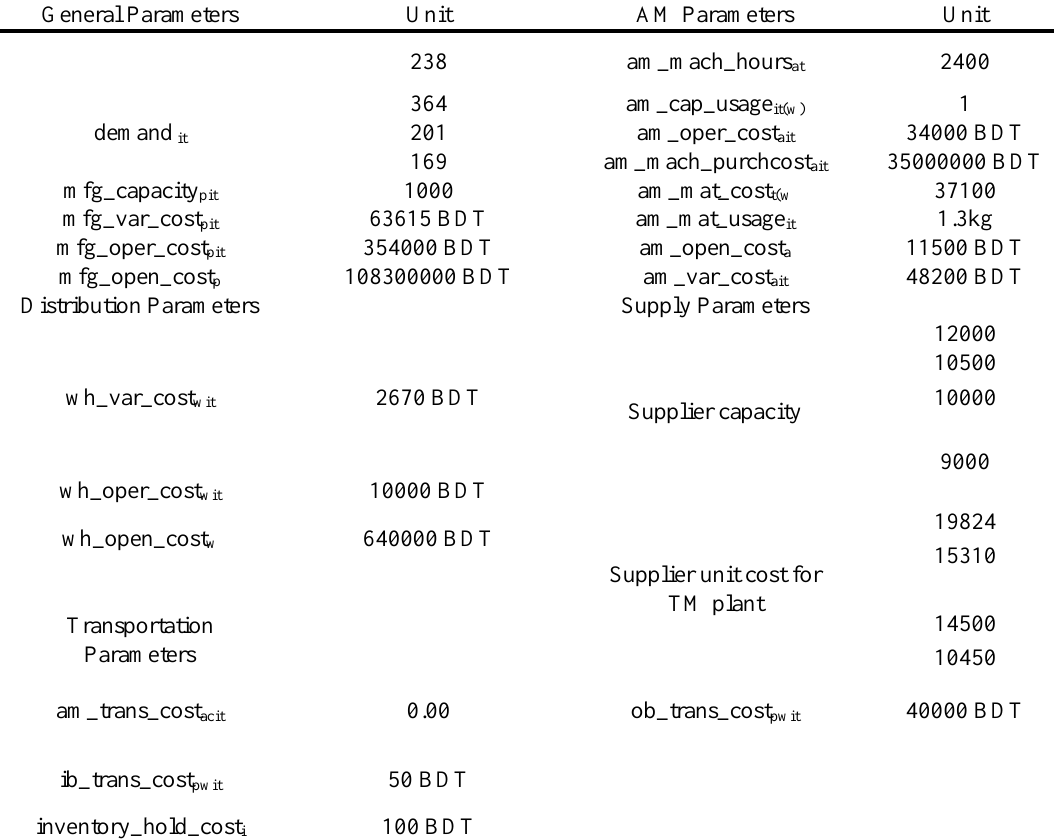
Table 1. Input parameter.